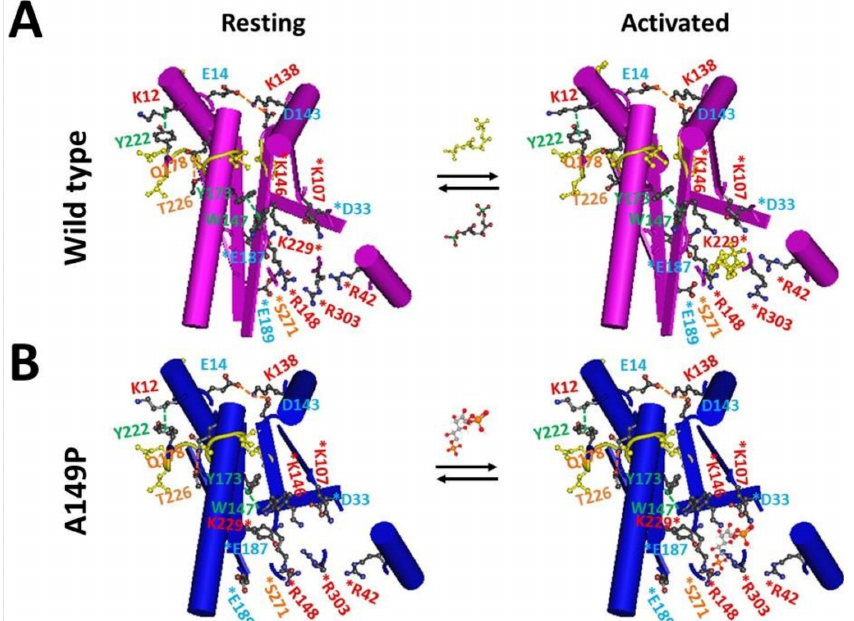
Figure 7. The tentative model for the activation of aldolase B and its mutant A149P upon the binding of Fru-1,6-P 2 . ( A ) The X-ray crystallographic structures of aldolase B in the absence (PDB ID: 1QO5) and presence of (PDB ID: 1FDJ) Fru-1,6-P 2 . [9,19]. ( B ) The X-ray crystallographic structures of